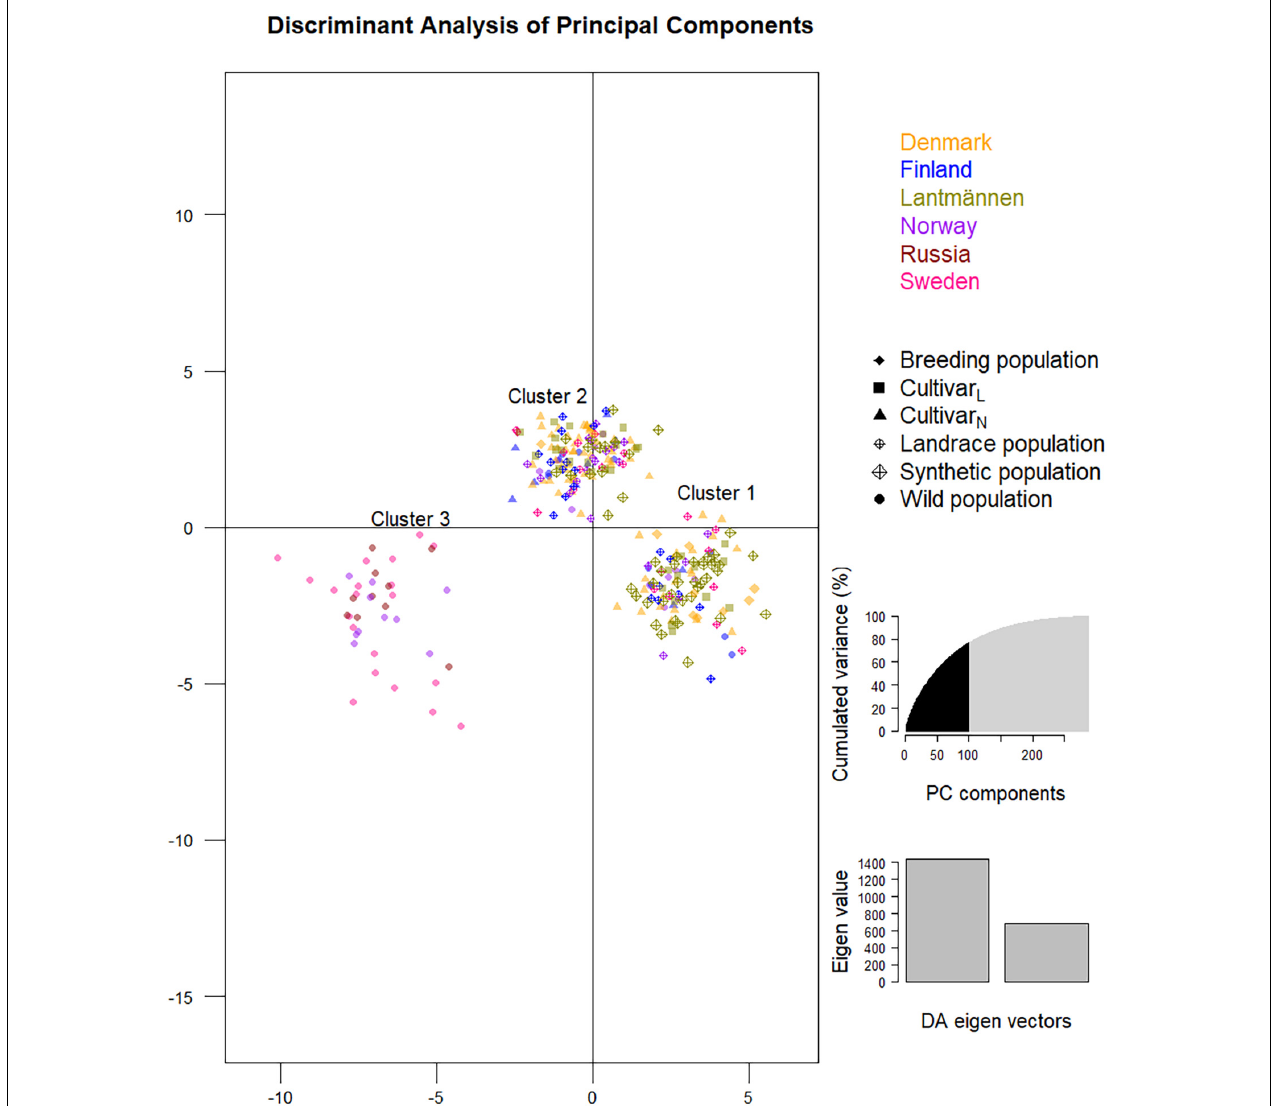
FIGURE 7 | A discriminant analysis of principal components (DAPC) depicting the clustering of the 288 red clover genotypes of the 29 accessions into three clusters. Genotypes sharing the same label-color belong to the same origin (a country or Lantmännen; see Figure key) whereas genotypes sharing the same label-shape belong to the same population type (see Figure key). The graph for the selection of 100 principal components and Eigenvalues of the discriminant analysis are shown on the